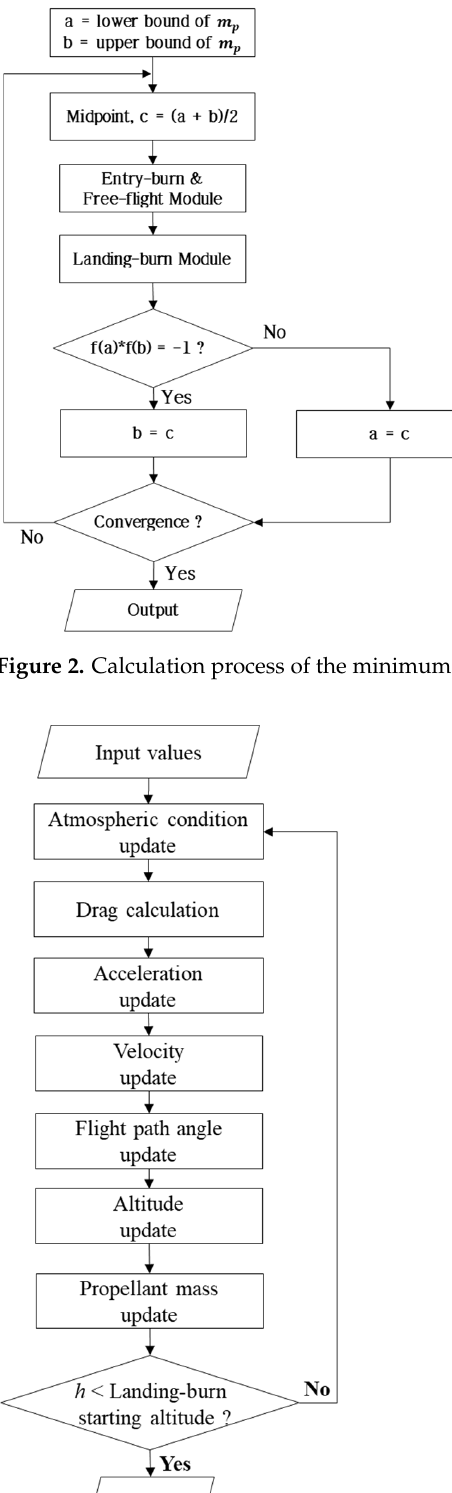
Figure 3. Calculation process of the entry-burn and free-fall flight modules.